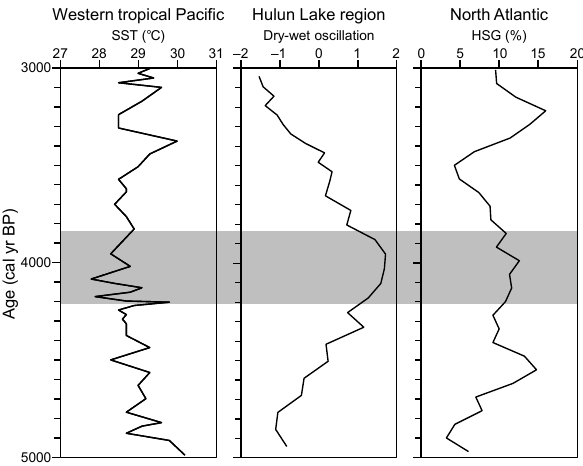
Figure 5. Correlation of dry–wet oscillation in the Hulun Lake region denoted by PCA F1 from the four proxies of the HL06 core with sea surface temperature (SST, ◦ C) reconstructed on the Mg / Ca ratio of Globigerinoides rubber from the MD98-2176 core in the western tropical Pacific (Stott et al., 2004) and hematite- stained grain concentration (HSG, %) in the VM29-191 core from the North Atlantic (Bond et al., 2001). The shaded bar marks the interval of a dry event occurring in the Hulun Lake region at 4210–